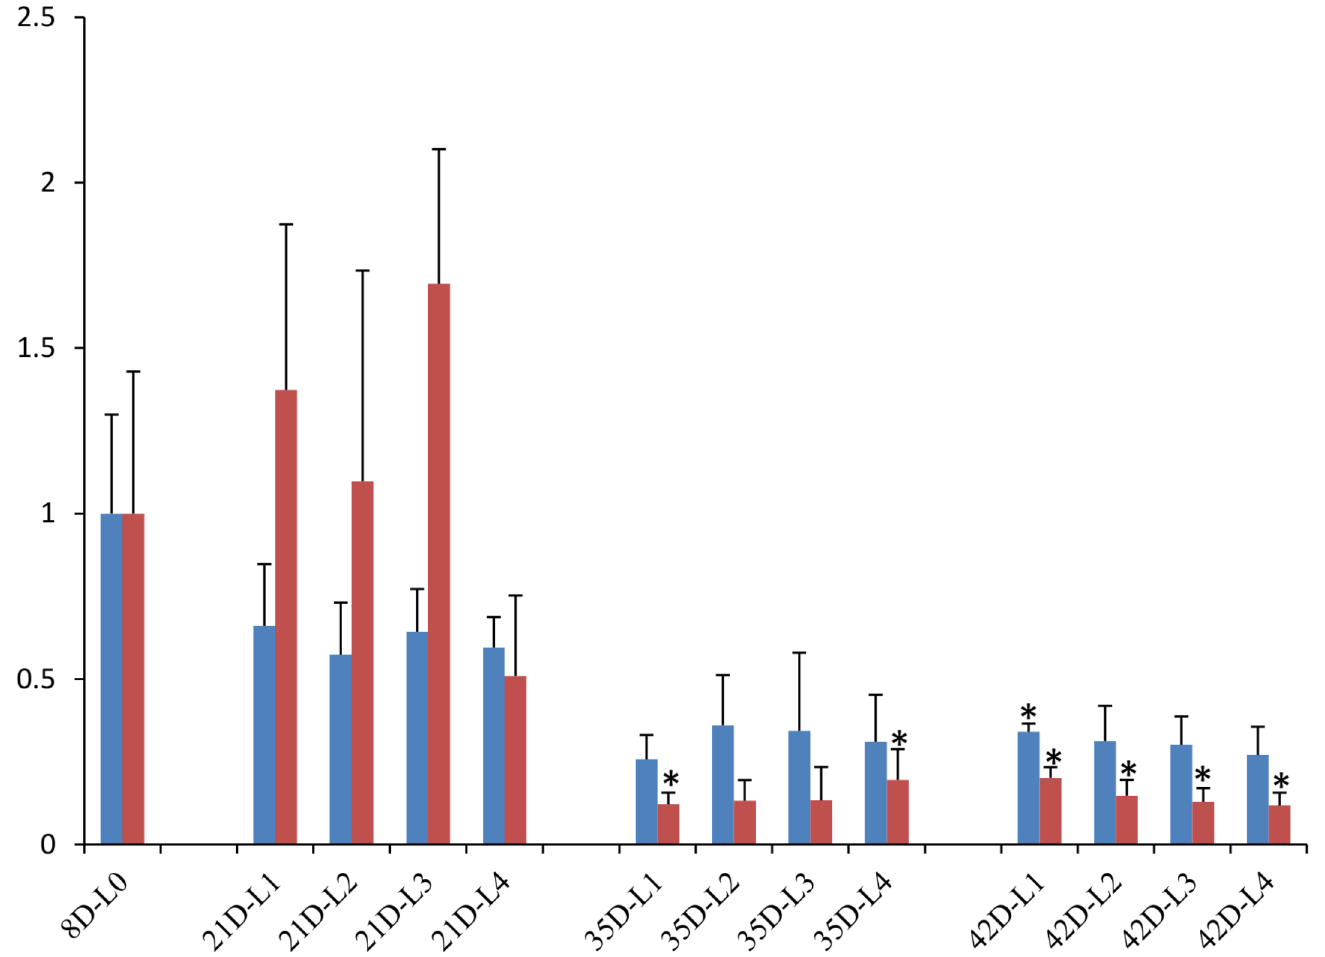
Fig 5. Relative expression of this MT-CO2 target gene when normalized with poor ranked reference genes and the best reference genes using Pfaffl method. This Figure shows the effect of incorrect selection of reference gene in the gene expression of target gene. Two best ranked reference genes (HMBS and HPRT1) and the two poor ranked reference genes (TFRC and B2M). The results also include standard errors (SE_R) and two-tailed P values by Student's t test. A single asterisk indicates P-value <